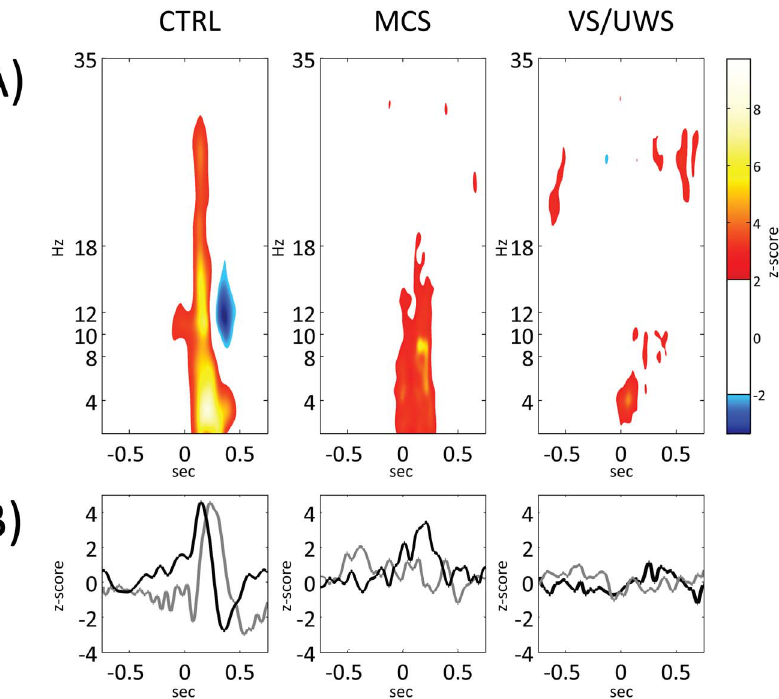
Figure 3. Group-averaged time-frequency z-scores maps (panel A), and time-course of both BRO and low-beta band (panel B). In panel A, groups grand-average z-scores time-frequency maps are depicted; Time-frequency bins with |z| , 1.96 , ( p . 0.05 ) were left uncoloured. Red to light yellow tones refer to z-scores from 2 to 8, whereas blue tones refer to z-scores less than -2. Each map is obtained as the mean intra-group z- score map (z-scores are evaluated with respect to baseline levels). Each plot of panel B refers to one group (first plot to CTRL, second to MCS and third to VS/UWS). In each plot the time course of both group-averaged low-beta z-scores (black line) and of group-averaged BRO (grey line) are depicted. As can be seen, a) the CTRL group shows a significant broadband BRS, followed by a significant BRD only in the 9–17 Hz range; b) the MCS group, shows a significant band-limited (up to 18 Hz) BRS, but totally lacks the subsequent BRD; and, finally, c) the VS/UWS group totally lacks any BRS/BRD.